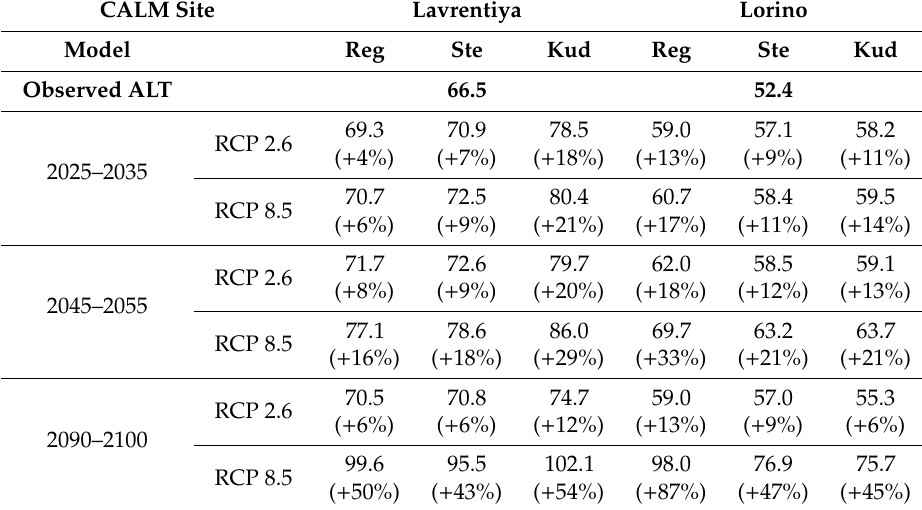
Table 8. Predicted seasonal thaw depths (cm) for the CALM sites of Eastern Chukotka and its changes in relation to the current